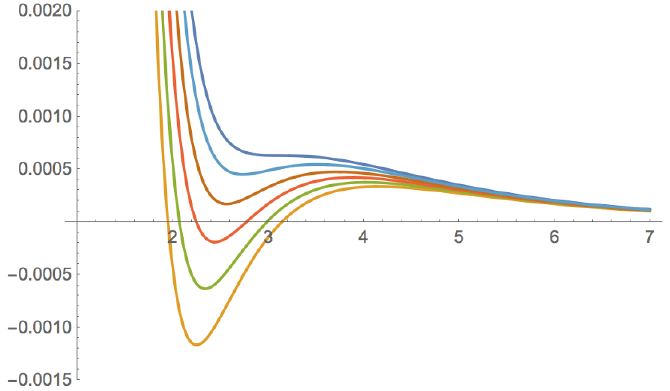
Figure 6 . The K(cid:127)ahler uplift of the potential V ( x ) for di(cid:11)erent values of C